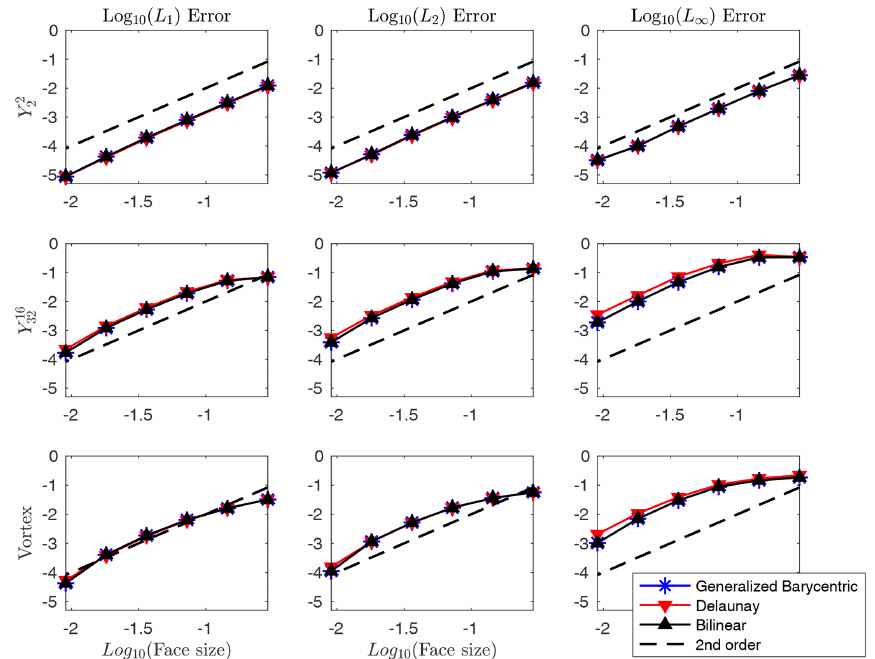
Figure 10. Convergence results for several non-integrated monotone remapping schemes for a fixed latitude–longitude target mesh and cubed sphere source meshes.